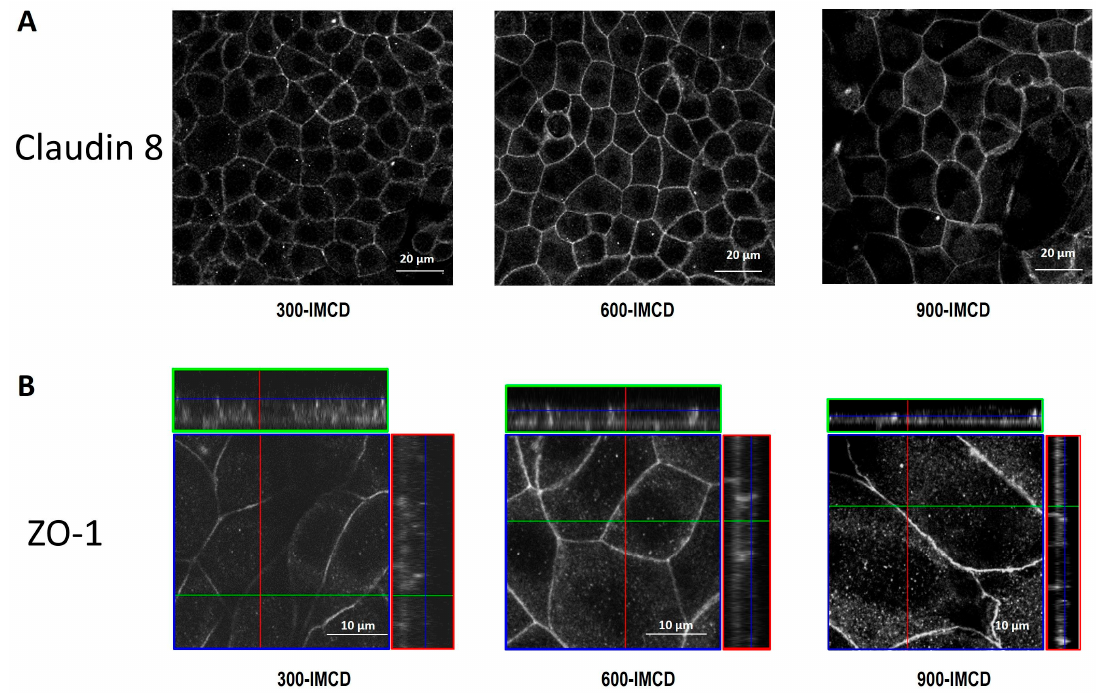
Figure 9. Immunofluorescence of claudin-8 in xy-overview in 300-IMCD, 600-IMCD, and 900-IMCD ( A ). Z-stacks of immunofluorescence of ZO-1 in 300-IMCD, 600-IMCD, and 900-IMCD ( B ).